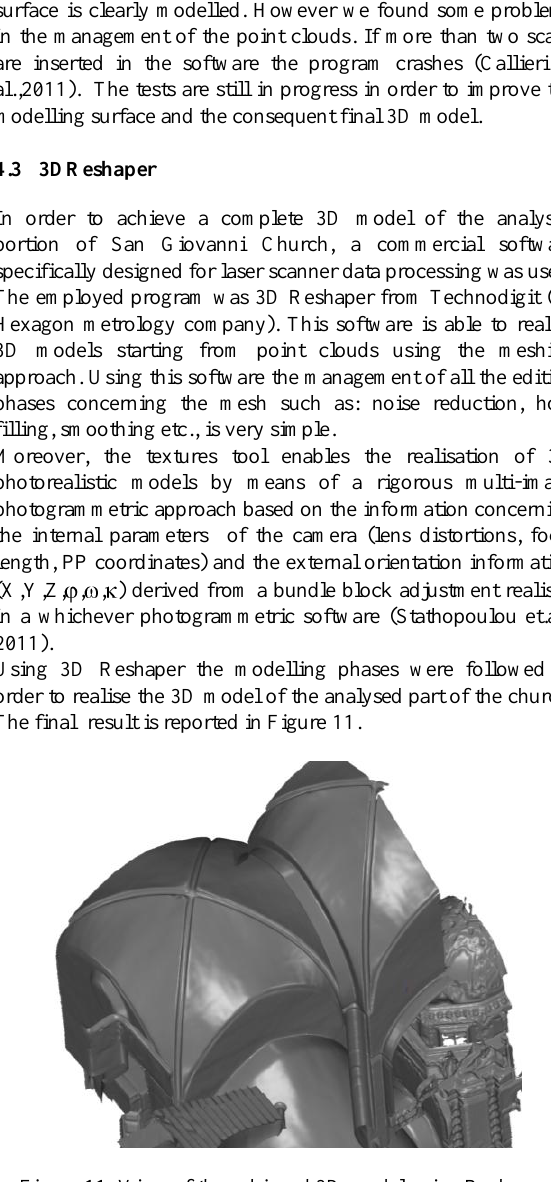
Figure 11. View of the achieved 3D model using